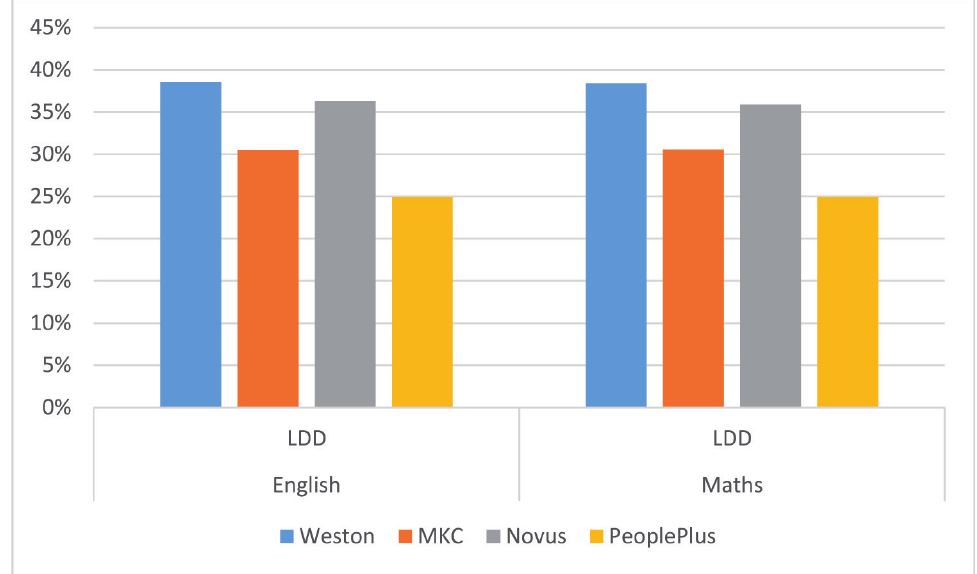
Figure 11: LDDself-assessmentsbyprovider